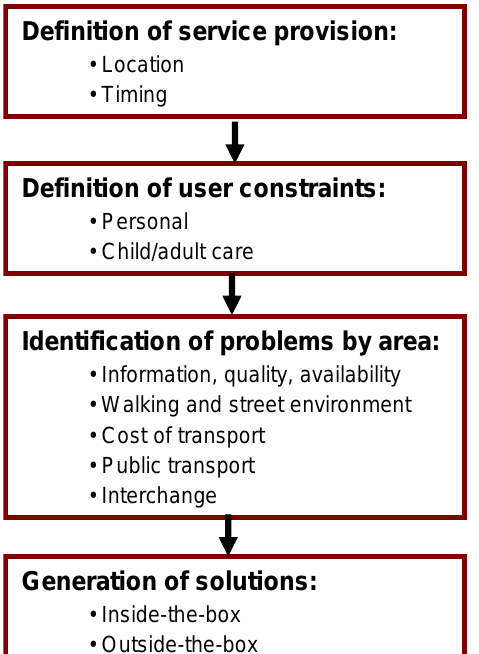
Figure 7. The main components of the spreadsheet tool Source: Jones and Paskins (2008), Figure